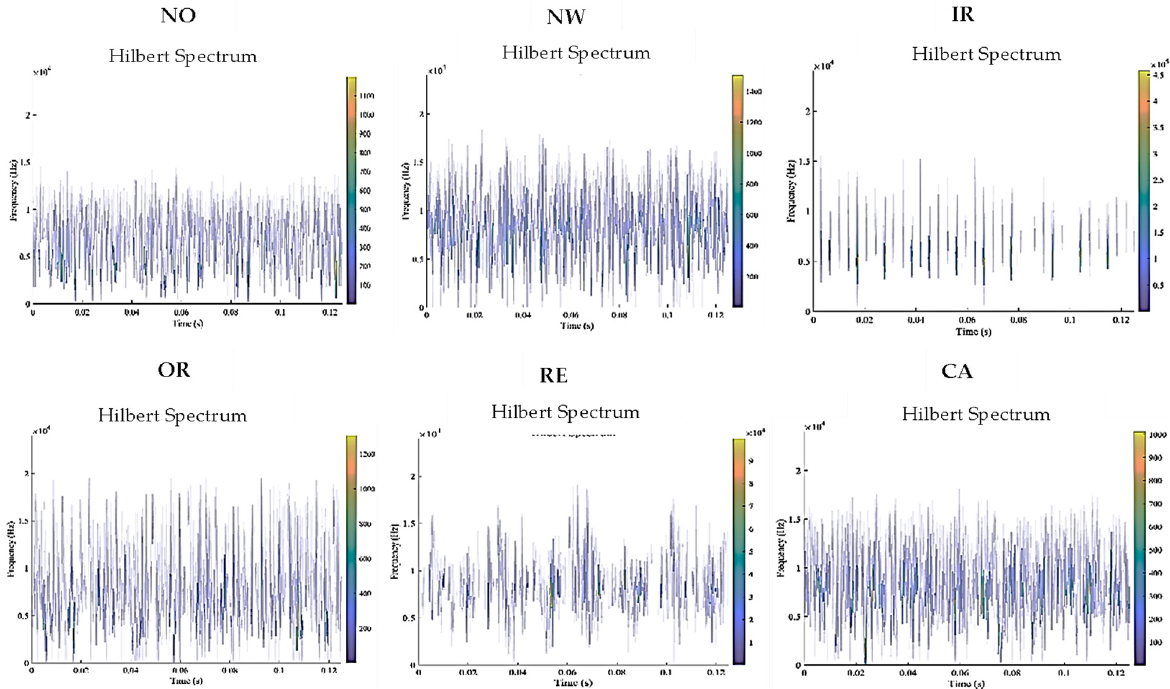
Figure 22. Examples of the produced Hilbert spectrums using HHT with EMD from bearing vibration signals with six health conditions that were described in Section 2.1.1 above.